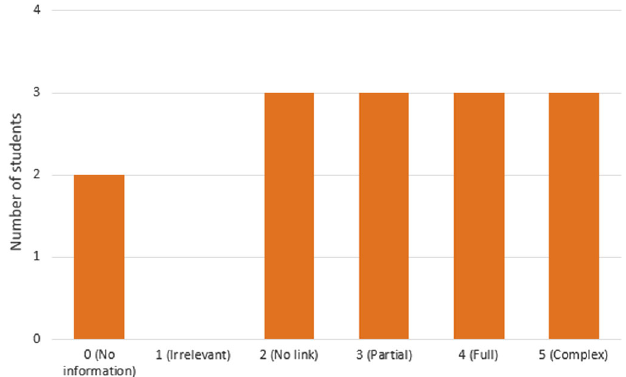
FIG. 2. Results for the task on the uncertainty principle (T1a “ Recognize that the presentation is not consistent with the current understanding of the principle and explain ”